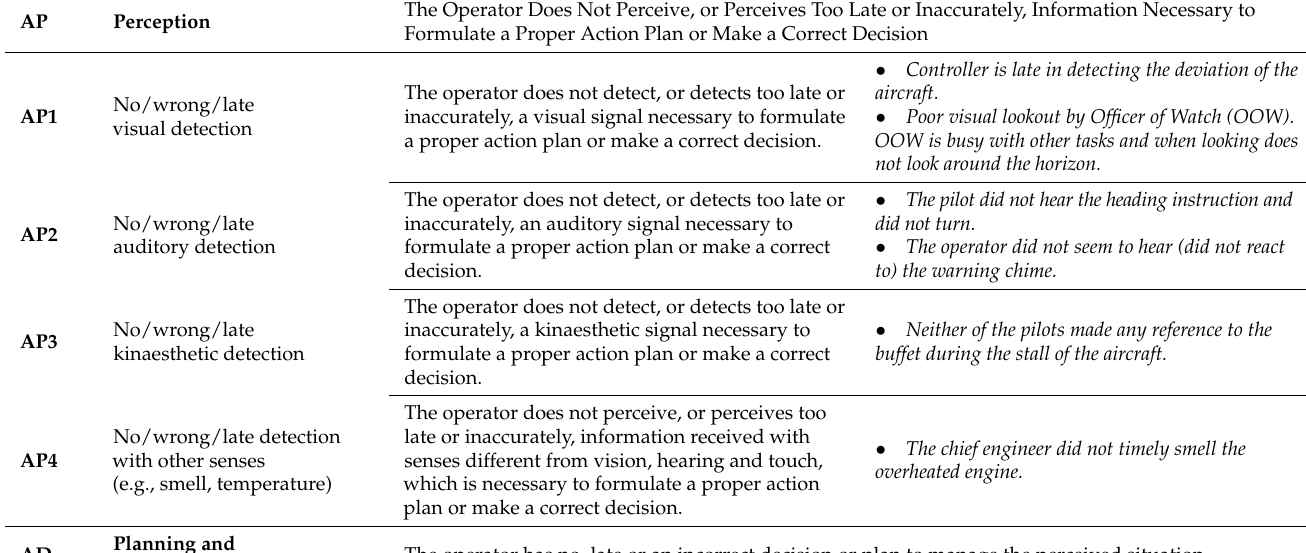
Table A1. Codes, titles, definitions, and guidance and examples of categories and factors in the Acts